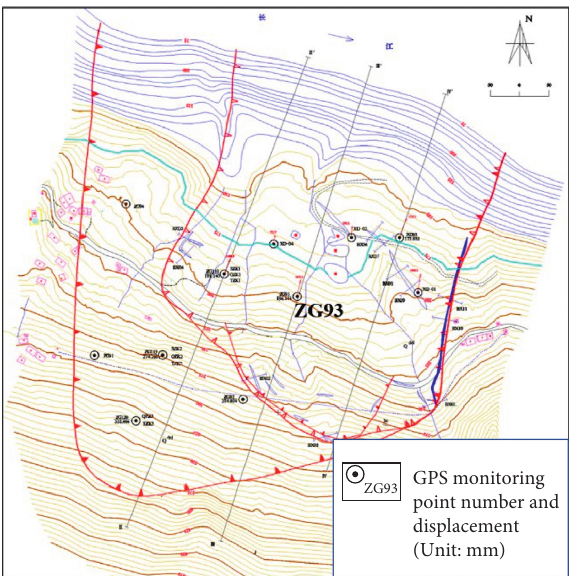
Figure 4: 2D map of Baishuihe landslide.